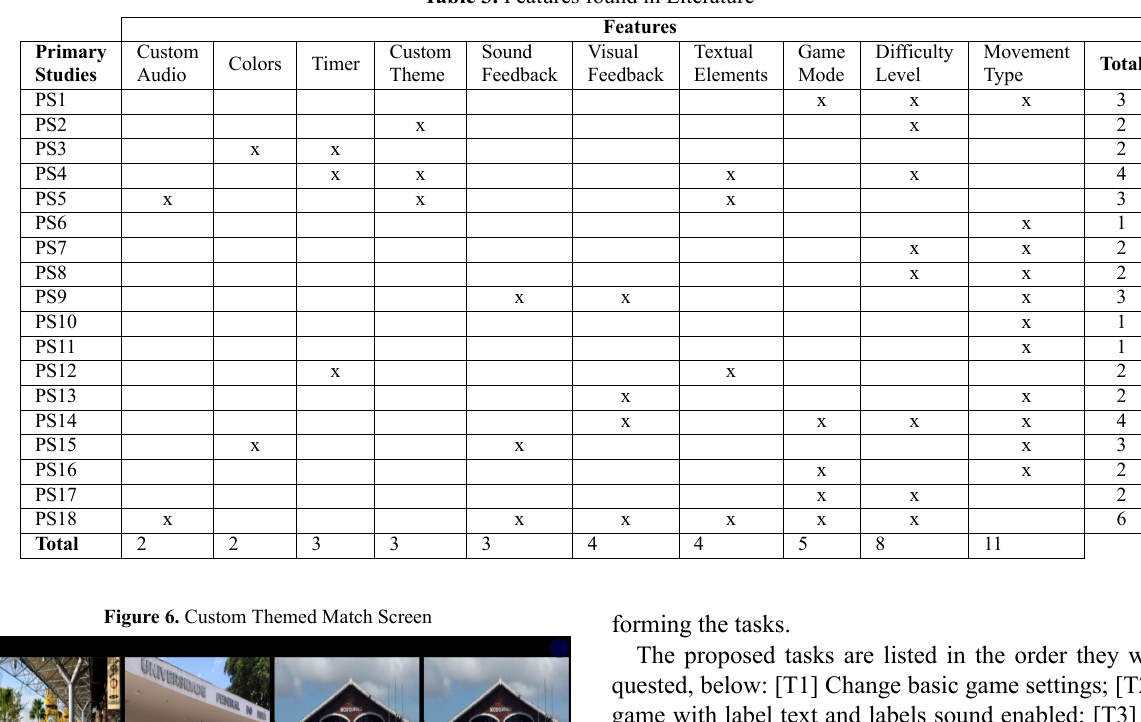
Table 3. Features found in Literature